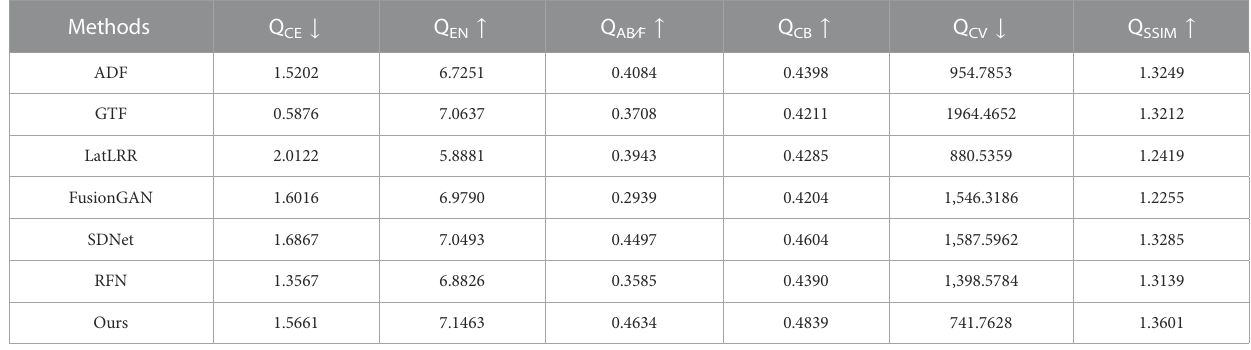
TABLE 2 Quantitative evaluation of different fusion methods on 10 pairs of images from RoadScence datasets. The red font indicates the optimal results and the blue font indicates the sub-optimal results.